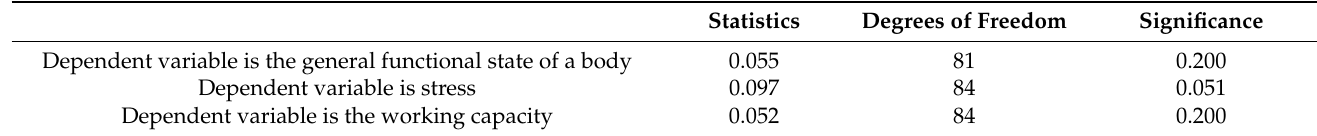
Table 6. Kolmogorov–Smirnov criteria for the normal distribution of